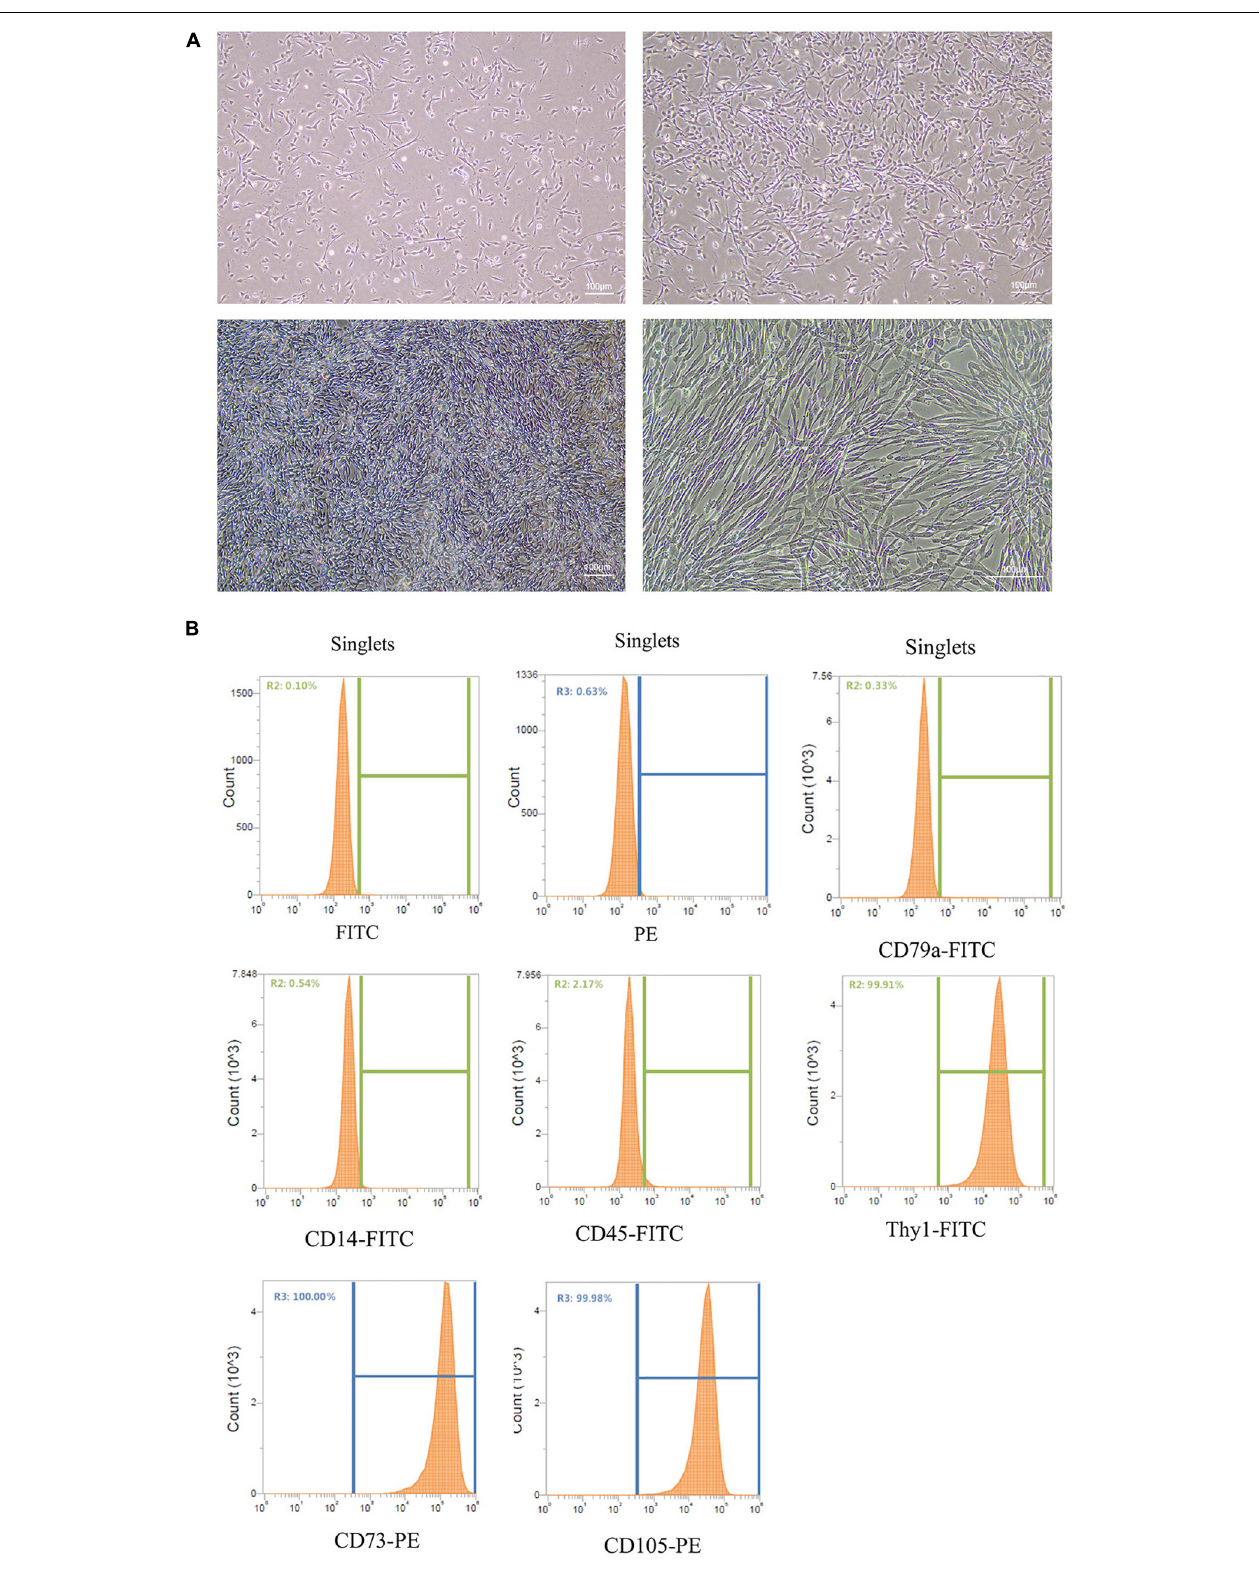
FIGURE 1 | Culture and identification of UC-MSCs. (A) Culture of UC-MSCs. Scale bar = 100 µ m. (B) Flow cytometry analysis showed that UC-MSCs were positive for CD105, Thy1 and CD73, but negative for CD79a, CD45 and CD14.